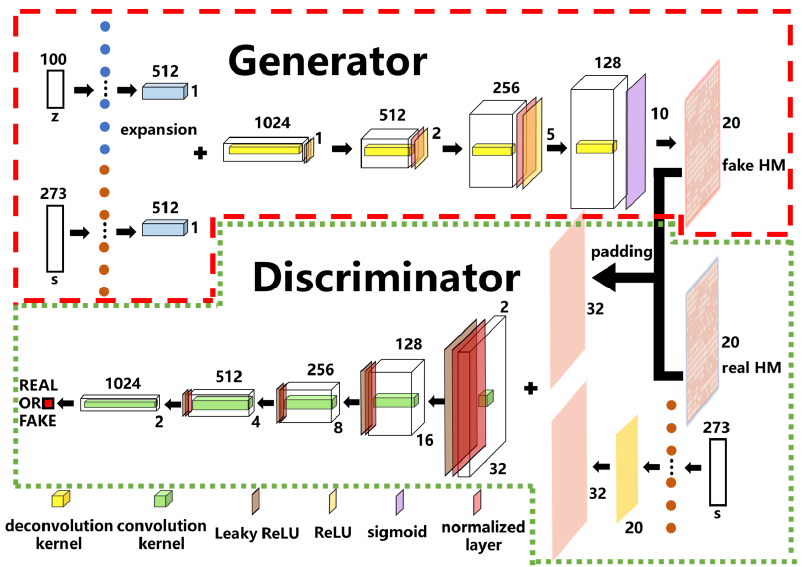
Figure 2. The schematic diagram of WGAN, where s = { T 1 , T 2 , R } is the target response as a conditional vector in the model and z is the latent variable. The fake HM is provided by the generator, whereas the real HM is taken from the training set. The dotted layers after s and z are used for the dimension expansion. The loss function for G is calculated by Equation (1) as minus the expectation value ( ) of D for all the generated fake HM samples x from the P G distribution. This is to make P G as close as possible to the real HM distribution P data .